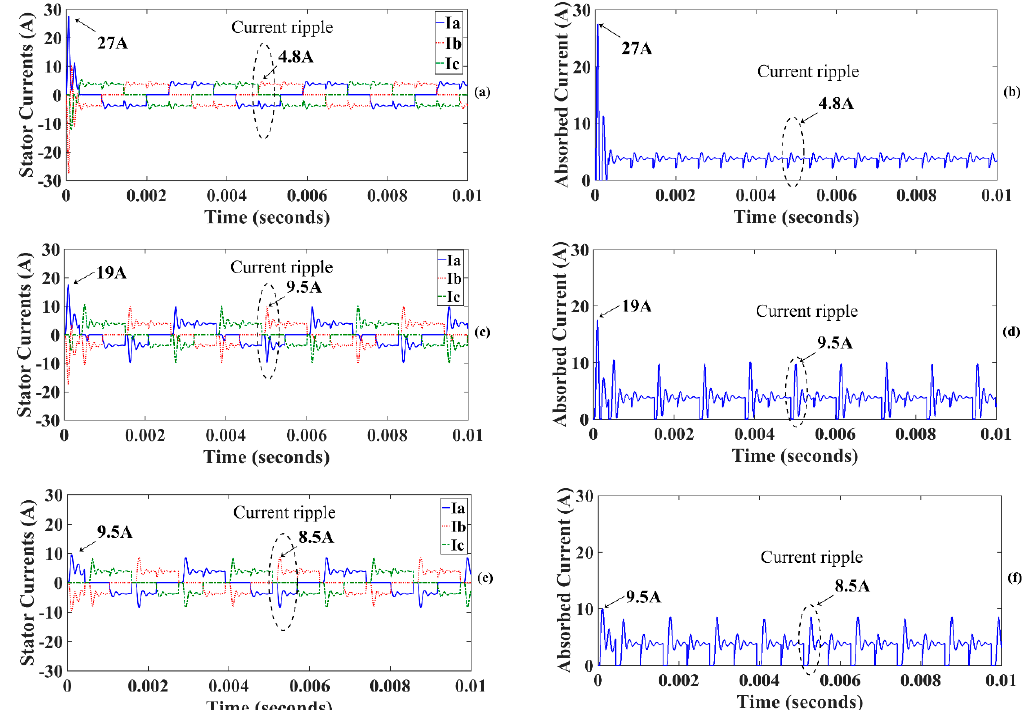
Figure 6. Current waveforms: ( a ) Phase currents without R-C filter, ( b ) absorbed current without R-C filter, ( c ) phase currents with R-C filter for C = 0.6 µF, ( d ) absorbed current with R-C filter for C = 0.6 µF, ( e ) phase currents with R-C filter for C = 1.5 µF, ( f ) absorbed current with R-C filter for C = 1.5 µF.